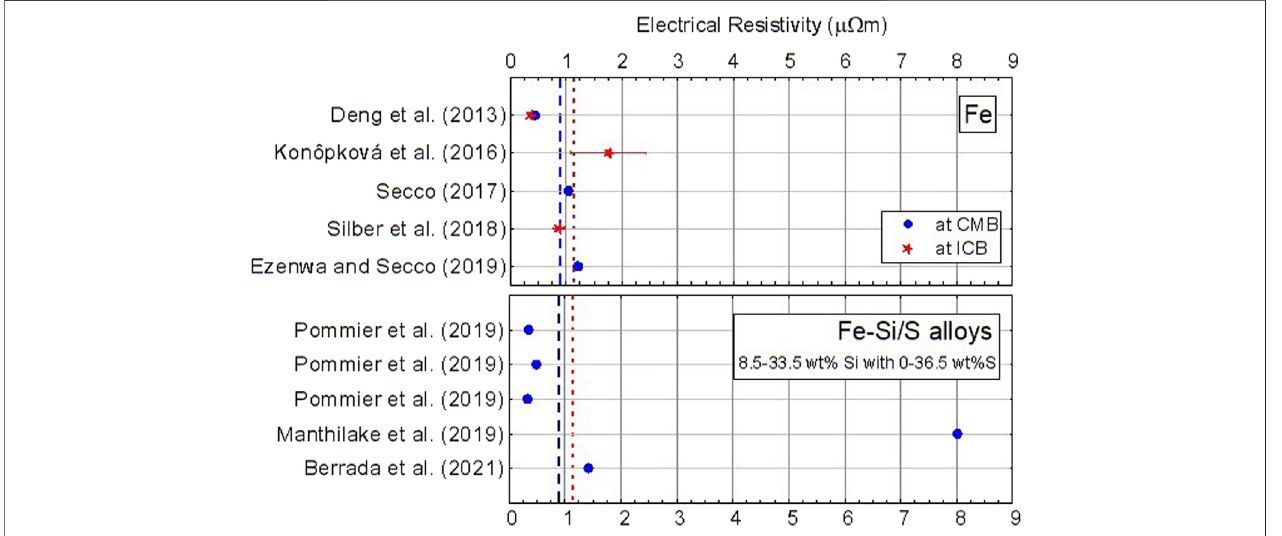
The ρ valuesassociatedwithstudiesthathavereported k valuesareobtained via theWiedemann-Franz lawwiththeSommerfeldvaluefortheLorenznumber.Valuesspeci fi ctoliquidFe are in red, those speci fi c to solid Fe are in blue , while unspeci fi ed values are in black. Compositions speci fi c to the fcc phase of Fe are denoted by c .